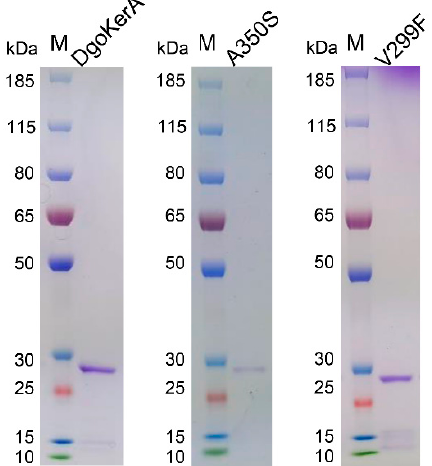
Figure 2. Alignment of the amino acid sequences of DgoKerA. The keratinases used were MtaKerA from M. taiwanensis WR-220 and BliKerA from B. licheniformis PWD-1. Sequence alignment showing structural elements of DgoKerA were generated with ESPript3.0 (https://espript.ibcp.fr/ESPript/ cgi-bin/ESPript.cgi (accessed on 7 November 2021)). The identical residues of all aligned proteins are shaded red. α , β , η , TT above the sequences represent α helix, β sheet, 310 -helices and β -turns, respectively. Positions of the starting residues of the mature protease (mature) was marked by black arrows at the bottom of the sequences.